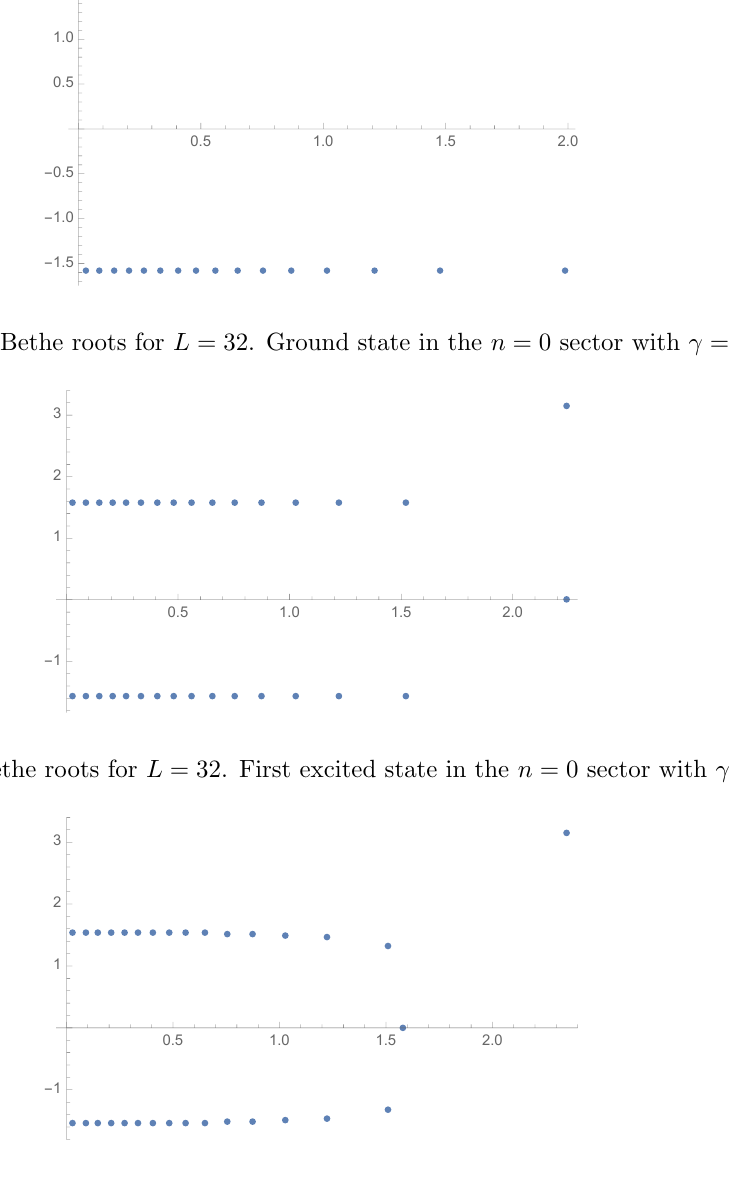
Figure 16 . Bethe roots for L = 32. Second excited state in the n = 0 sector with (cid:13) = (cid:25)